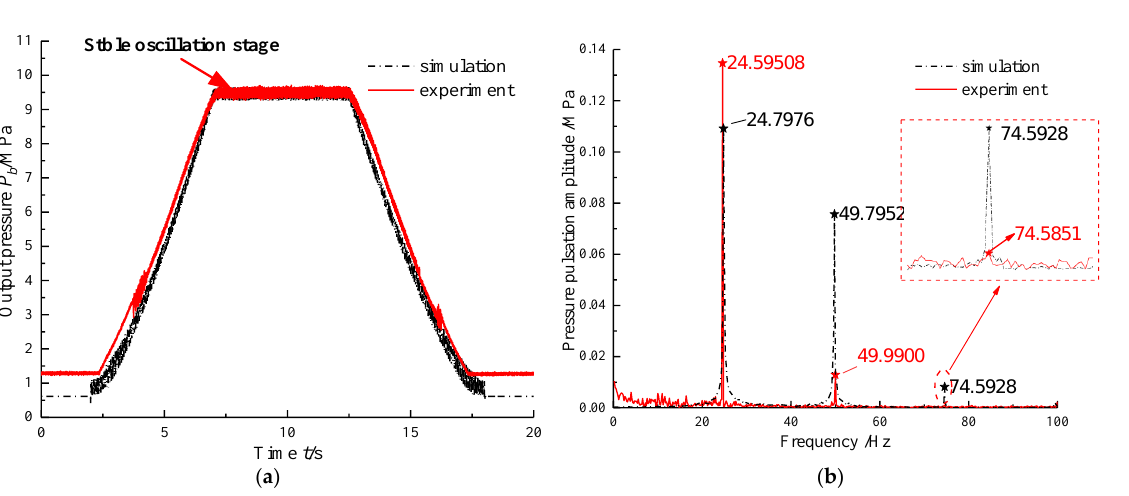
Figure 9. Experimental results of output pressure under ramp signal: ( a ) Time domain curve, ( b ) FFT spectrum of output pressure.